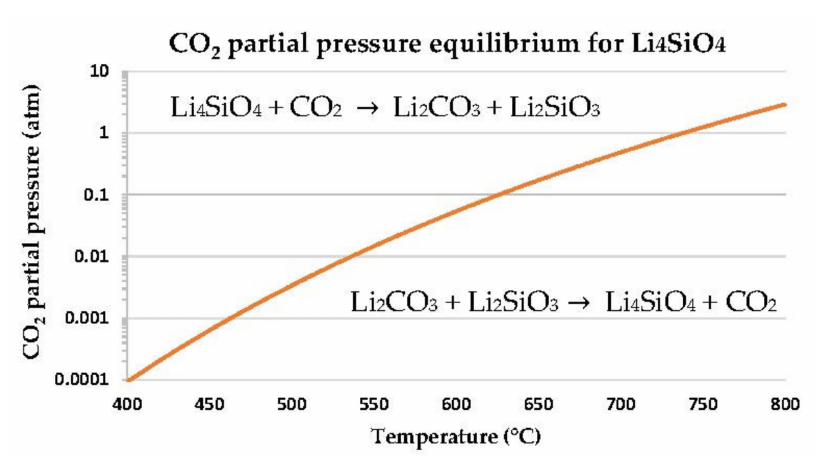
Figure 11. Equilibrium partial pressure of CO 2 from Li 4 SiO 4